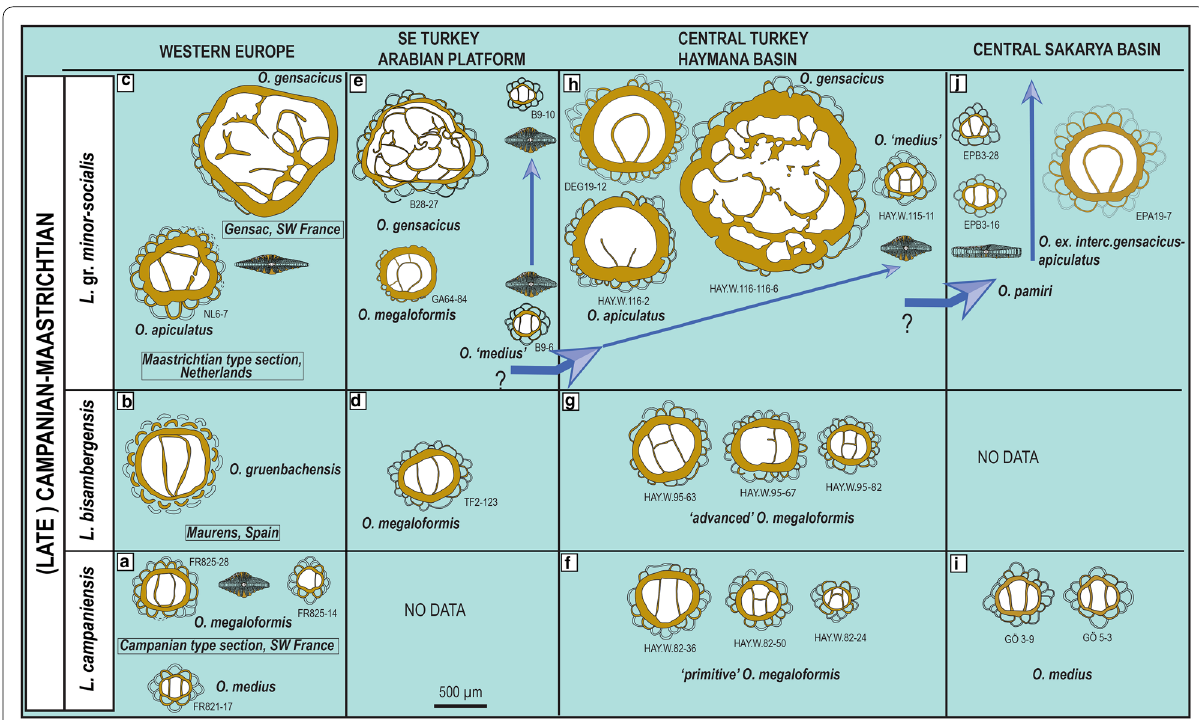
Fig. 23 Panel showing the tentative relations of Orbitoides species from the late Campanian to late Maastrichtian along the Arabian Plate margin, Turkey and Western Europe. Arrows show possible offshoots from the main Orbitoides lineage in the Maastrichtian, represented by O. ‘medius’ and O. pamiri . Orbitoides gensacicus from Gensac is not into scale. Data from Campanian and Maastrichtian type sections and from Gensac (SW France) are from van Hinte (1966b) and Eggink and Baumfalk (1983). The O. gruenbachensis population from Maurens, Spain is from Caus et al. (1996). The prefix ‘GÖ’ is for Orbitoides medius populations from the upper Campanian of the Central Sakarya Basin (unpublished data of EÖ and AOY). Details of samples HAY.W.82, 95, 115, 116 from the Haymana Basin are given in Özcan and Özkan-Altıner